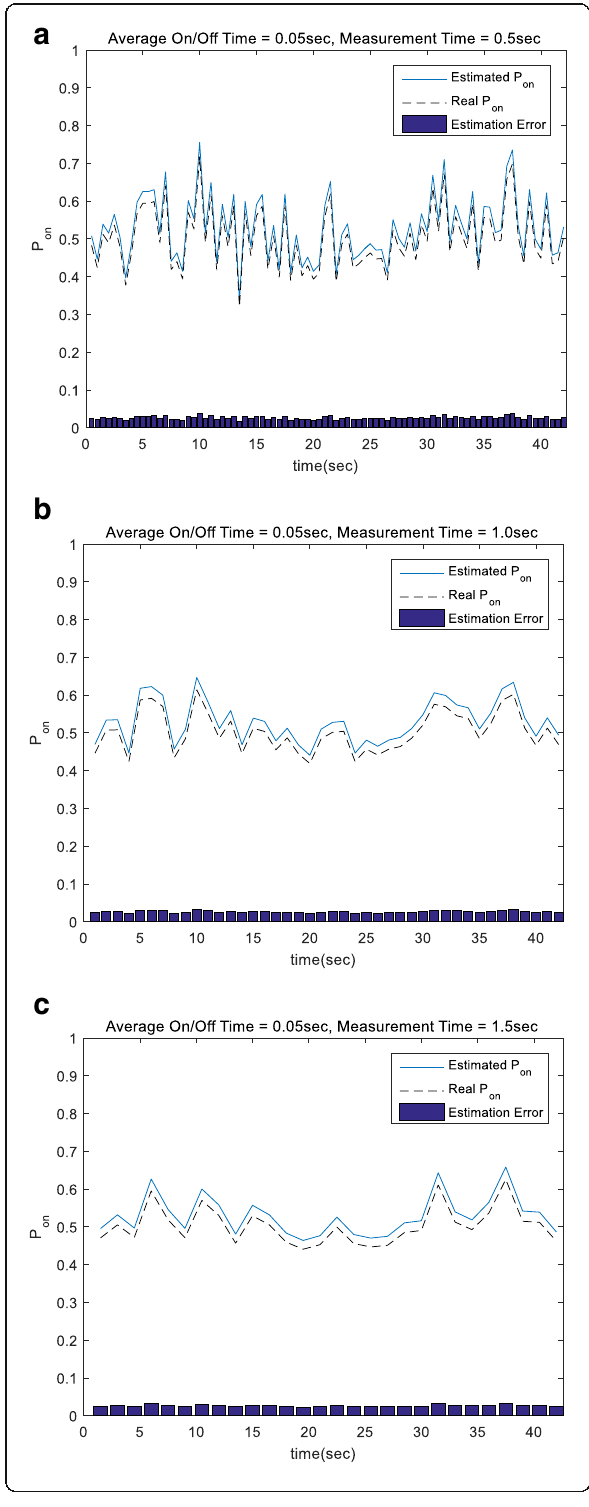
Fig. 10 Comparison between estimated and real P on . a Measurement time=0.5 s. b Measurement time=1 s. c Measurement time=1.5 s. We must calculate the P on to accurately calculate the interference ratio and the transmission opportunity loss ratio. Therefore, P on ’ s estimation must also be accurate. The average on/off cycle of the PU is 0.05 s. The measurement time is 0.5 s in a , 1 s in b , and 1.5 s in c . For each case, the solid line represents the estimated P on , the dashed line represents the actual P on , and bar represents the estimation error. a , b , and c indicate that the proposed method accurately estimate the real P on . As the measurement time becomes longer, the change of the value decreases by the